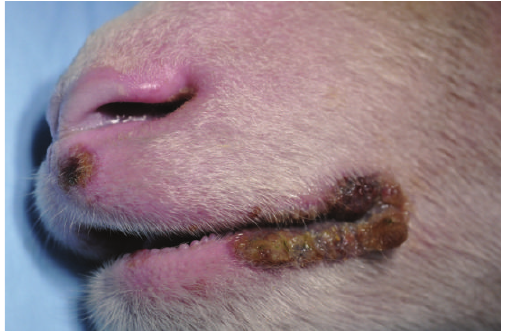
Figure 3: Prepuce. Multifocal necrotizing and proliferative posthi- tis.